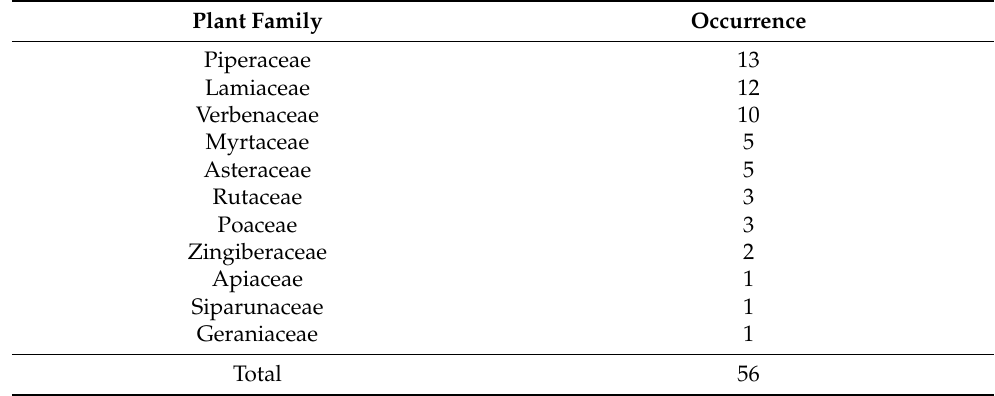
Table 1. Occurrence of families whose essential oil has been studied as an insecticide against Spodoptera frugiperda .